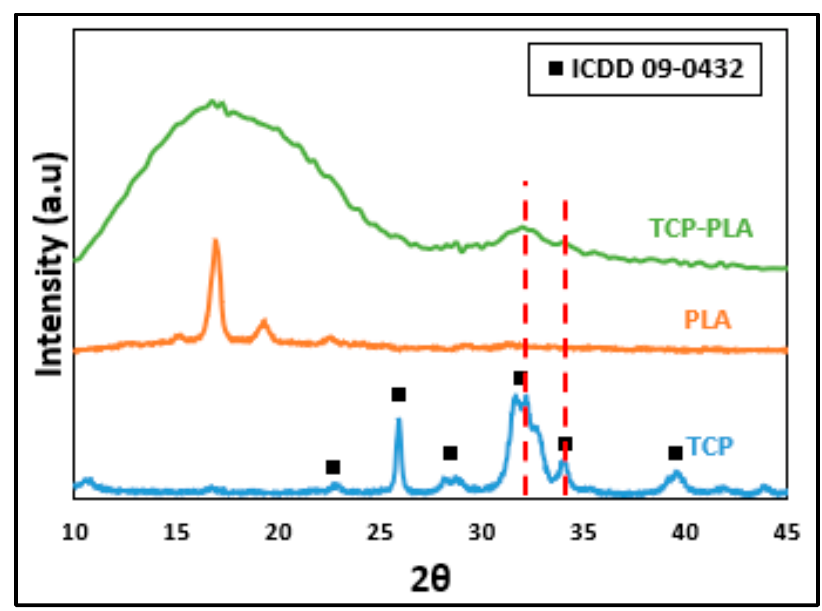
Figure 5. FTIR data of TCP, PLA, and TCP–PLA.